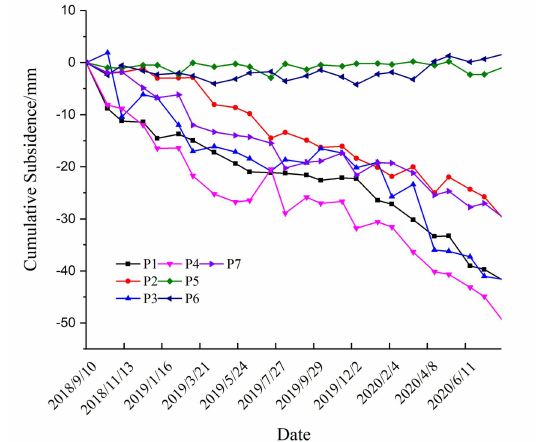
Figure 6. Cumulative surface subsidence of each study point .